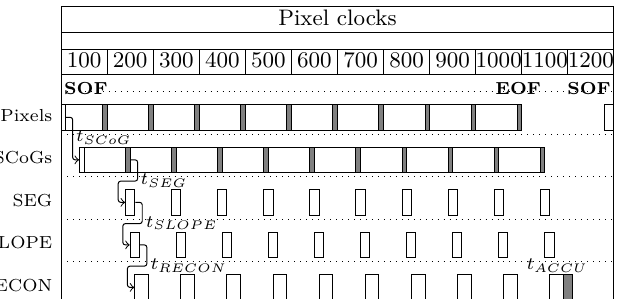
Figure 9. Time delay between different modules in the SHWFS implementation. Note that the whole wavefront sensing operation finishes shortly after End-Of-Frame (EOF) and before the next Start-Of-Frame